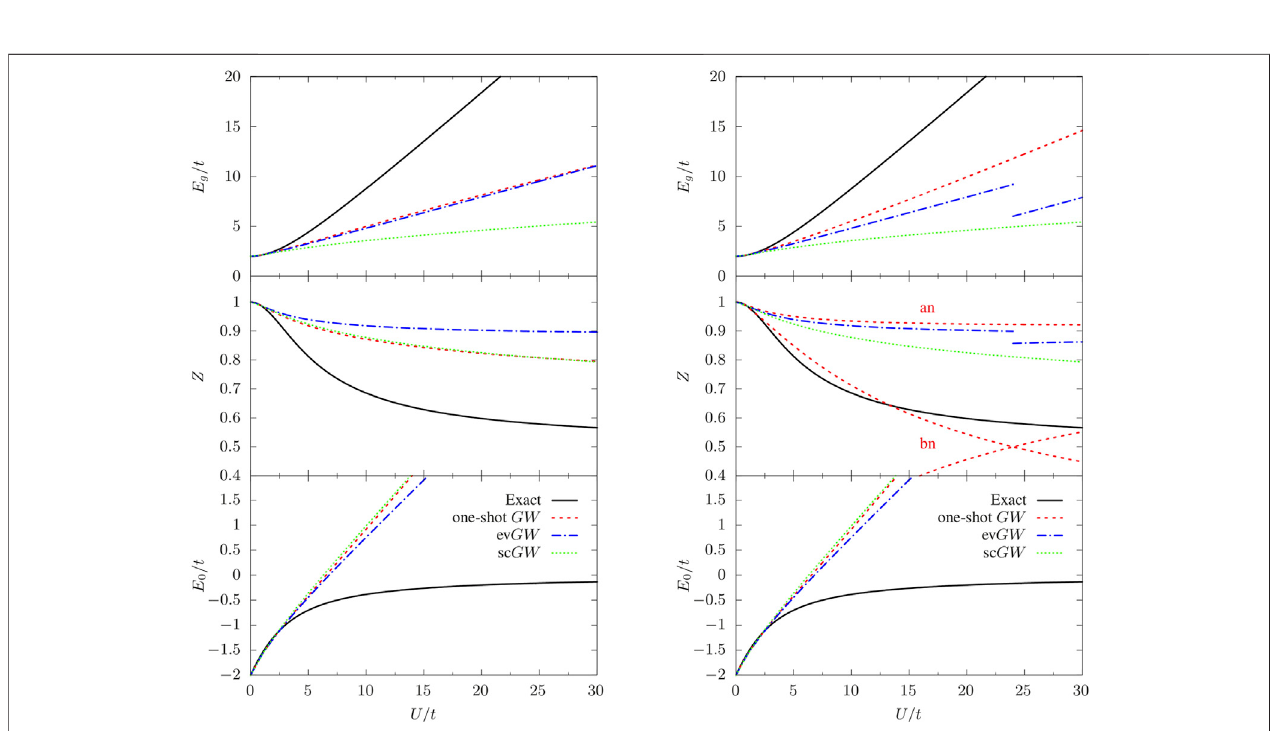
Frontiers in Chemistry |